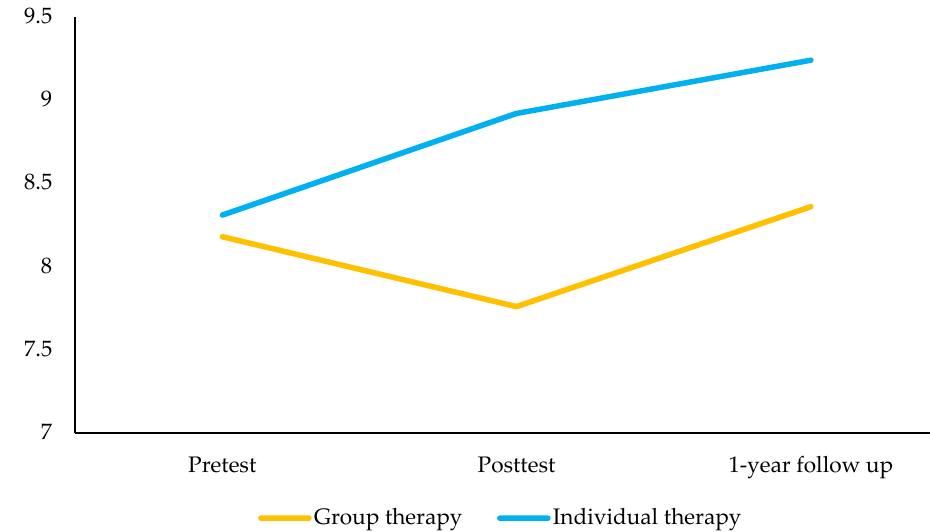
Figure 2. Estimated marginal means of the peer problems score between pretest, posttest, and 12-months follow-up by therapy condition.